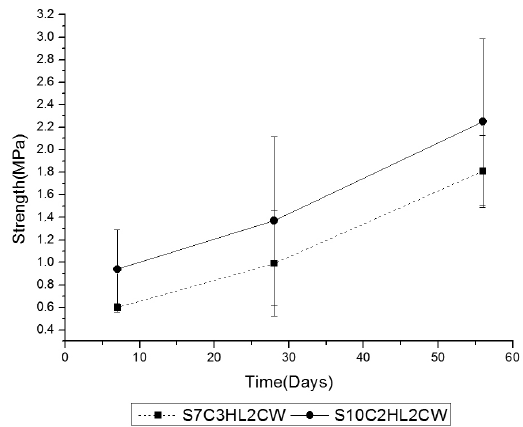
Figure 6. Strength of soil-cement-lime and CW